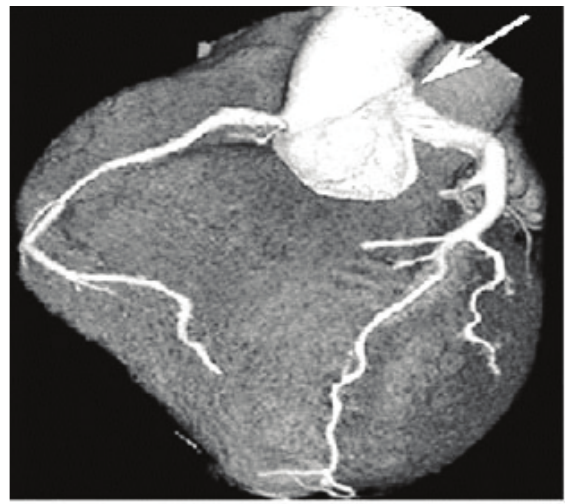
Figure 2. AngioCAT – Arrow – Adequate graft patency (combined pulmonary tissue and bovine pericardium patch).